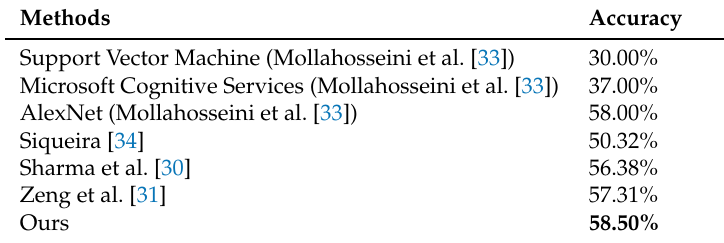
Table 3. Classification accuracy (%) of facial expressions on Affectnet validation set (the bold value indicates the best classification